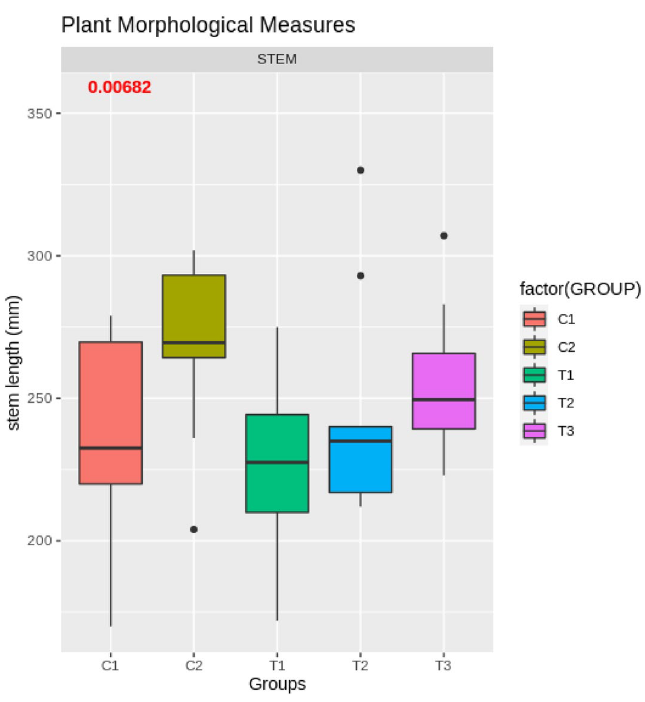
Figure 9. Test bed distribution of stem length (mm) as function of the treatment group (T1–T3) or control group (C1,